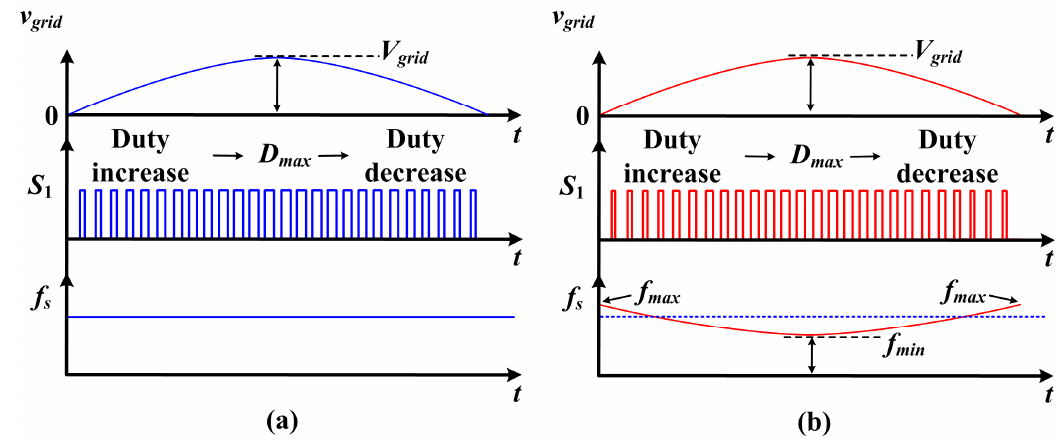
Figure 9. ( a ) Fixed and ( b ) variable switching frequency controls.